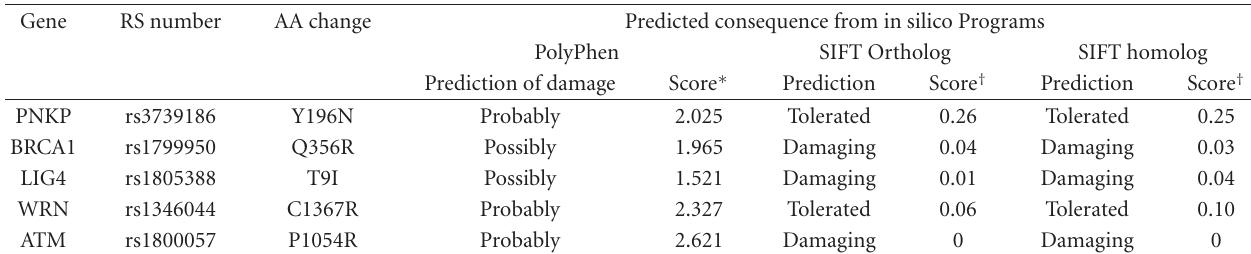
Table 1: Selected nsSNPs and consequences based on in silico